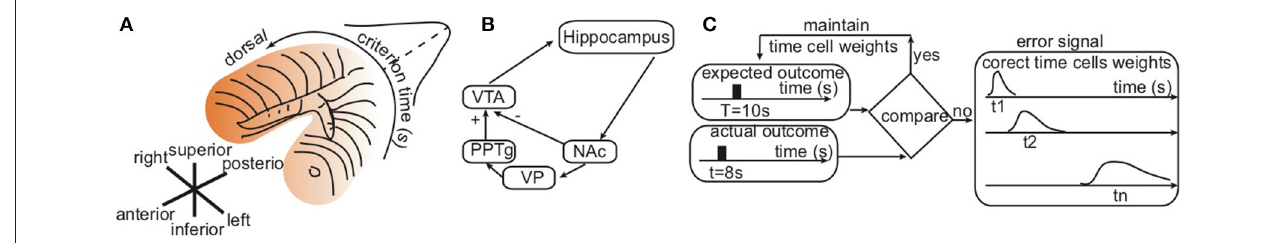
FIGURE 1 | Hippocampal topological map and basal ganglia–hippocampal loops. (A) Consistent with hippocampus lesions experiments, the sketch of the hippocampus with color shading suggesting that shorter durations are stored in the ventral area and longer durations orderly stored in the dorsal area. (B) Simplified basal ganglia–hippocampal loops with direct projection to the nucleus accumbens (NAc), which performs a decision task by comparing the predicted and the actual outcomes of behavior. If the outcome is as expected, the result is an inhibition (“ ”) of ventral tegmental area (VTA). Otherwise, an error correction loop that includes − the ventral pallidum (VP) and the pedunculopontine nucleus (PPTg) excites (“ ”) VTA. (C) Symbolic representation of computations performed by the basal + ganglia-hippocampus loops in order to correct the activity of time cells such that the average time field peaks around the to-be-memorized criterion time T . An error signal proportional to the distance between the expected peak time T and the actual peak times t 1 , t 2 , ... , t n of individual time cells changes the weights of the contribution of the individual time